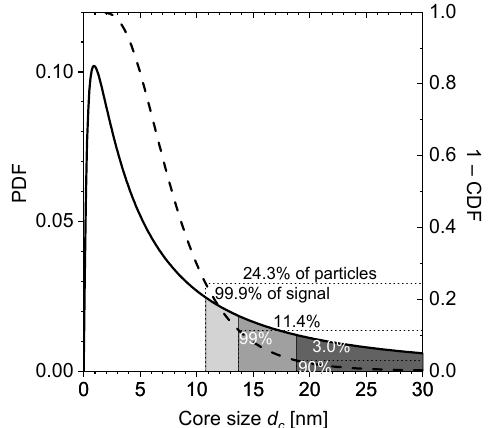
Figure A2. PDF of lognormal distribution (solid line) with d 0 = 7.81 nm and σ = 1.466 and its reverse CDF, counted from large sizes (dashed line). The quantiles which yield 90% (99%; 99.9%) of the FMMD signal are shaded in dark grey (grey; light gray), they consist of 3.0% (11.4%; 24.3%) of particles on the large-sized tail of the distribution. For this wider distribution, it was found that the largest 3.0% of the particles (with 𝑑 (cid:3030) > 18.8 nm) contribute 90% of the FMMD signal. The largest 11.4% of particles (with 𝑑 (cid:3030) > 13.7 nm) contribute 99% of signal. Almost all of the signal (99.9%) is generated by the largest 24.3% of the particles above 10.8 nm core size.